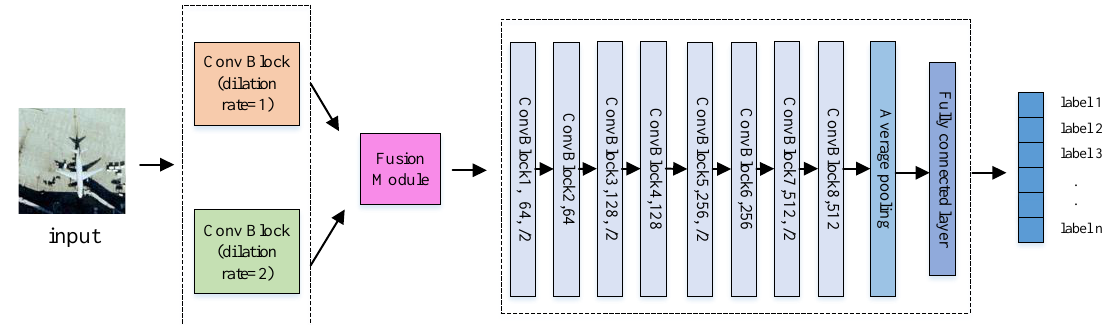
Figure 2. Overview of the proposed method.